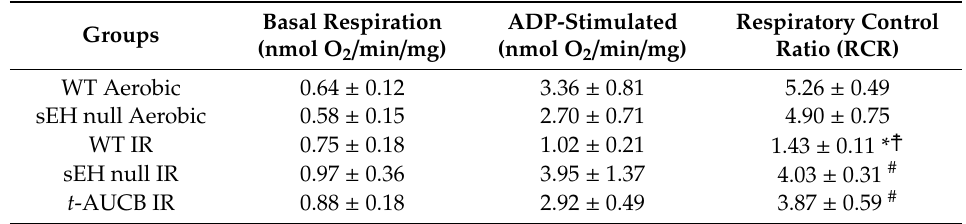
Table 1. Mitochondrial respiration was measured in permeabilized cardiac fibers freshly isolated at the end of reperfusion.